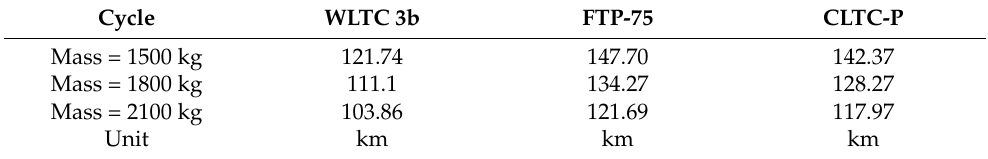
Table 9. Electric drive range in WLTC 3b, FTP-75, and CLTC-P for three variants of vehicle